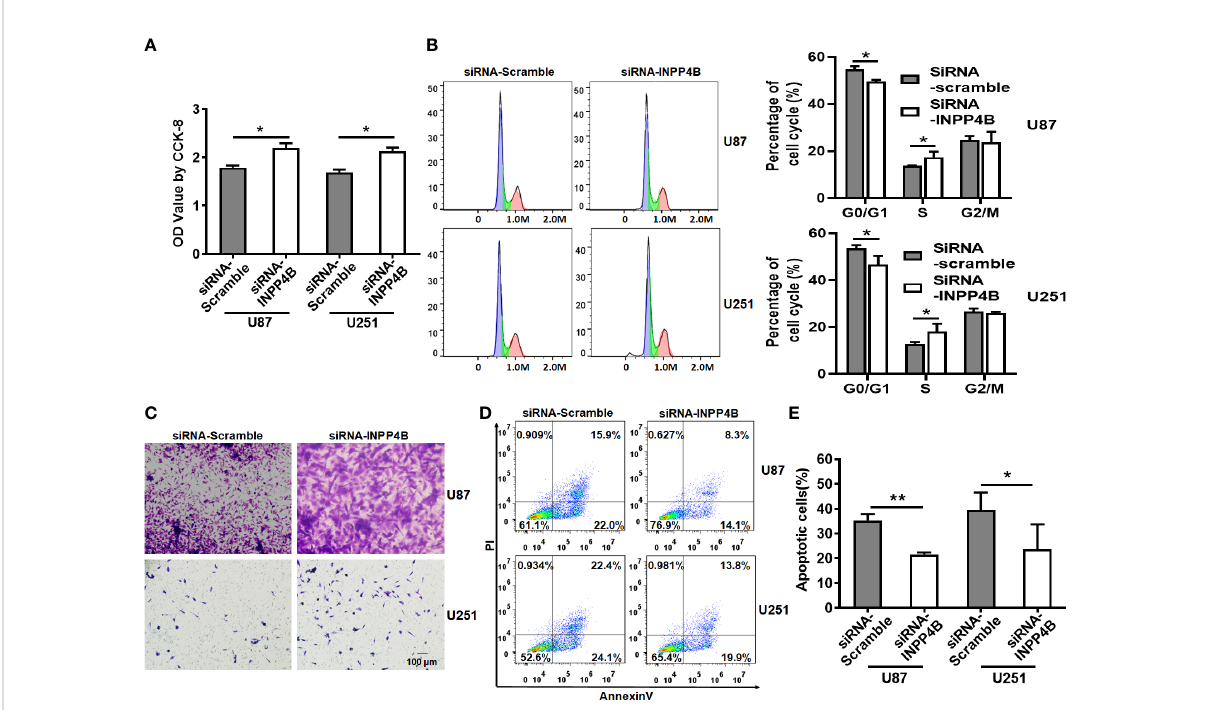
FIGURE 3 INPP4B knockdown promotes the proliferation and migration glioma cells and decreases their susceptibility to apoptosis. (A) CCK-8 assay on U87 and U251 cells transfected with siRNA-Scramble or siRNA-INPP4B. (B) Cell growth evaluated by cell cycle assay. (C) Migration of U87 and U251 cells after transfection with siRNA-Scramble or siRNA-INPP4B. (D, E) Effect of INPP4B knockdown on apoptosis in U87 and U251 cells, assessed by Annexin V/PI staining and fl ow cytometry. Values represent the means ± SD (n = 3). * p < 0.05, ** p <